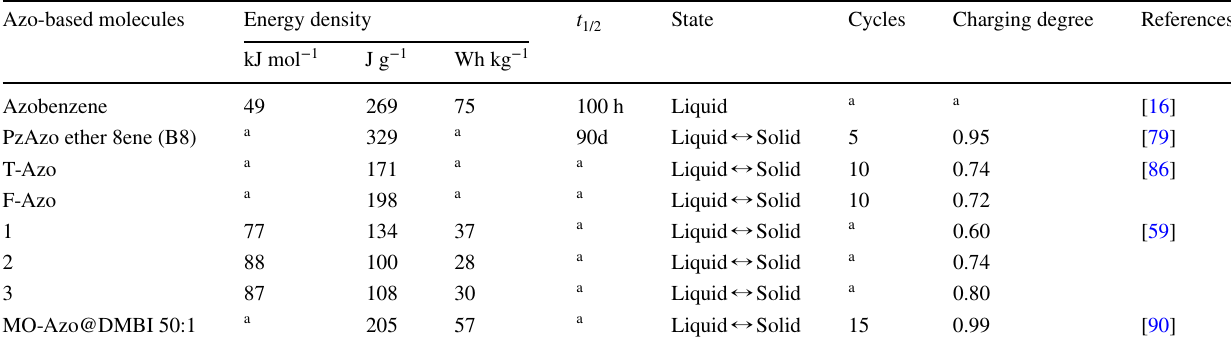
Table 1 Parameters related to azobenzene derivative STFs